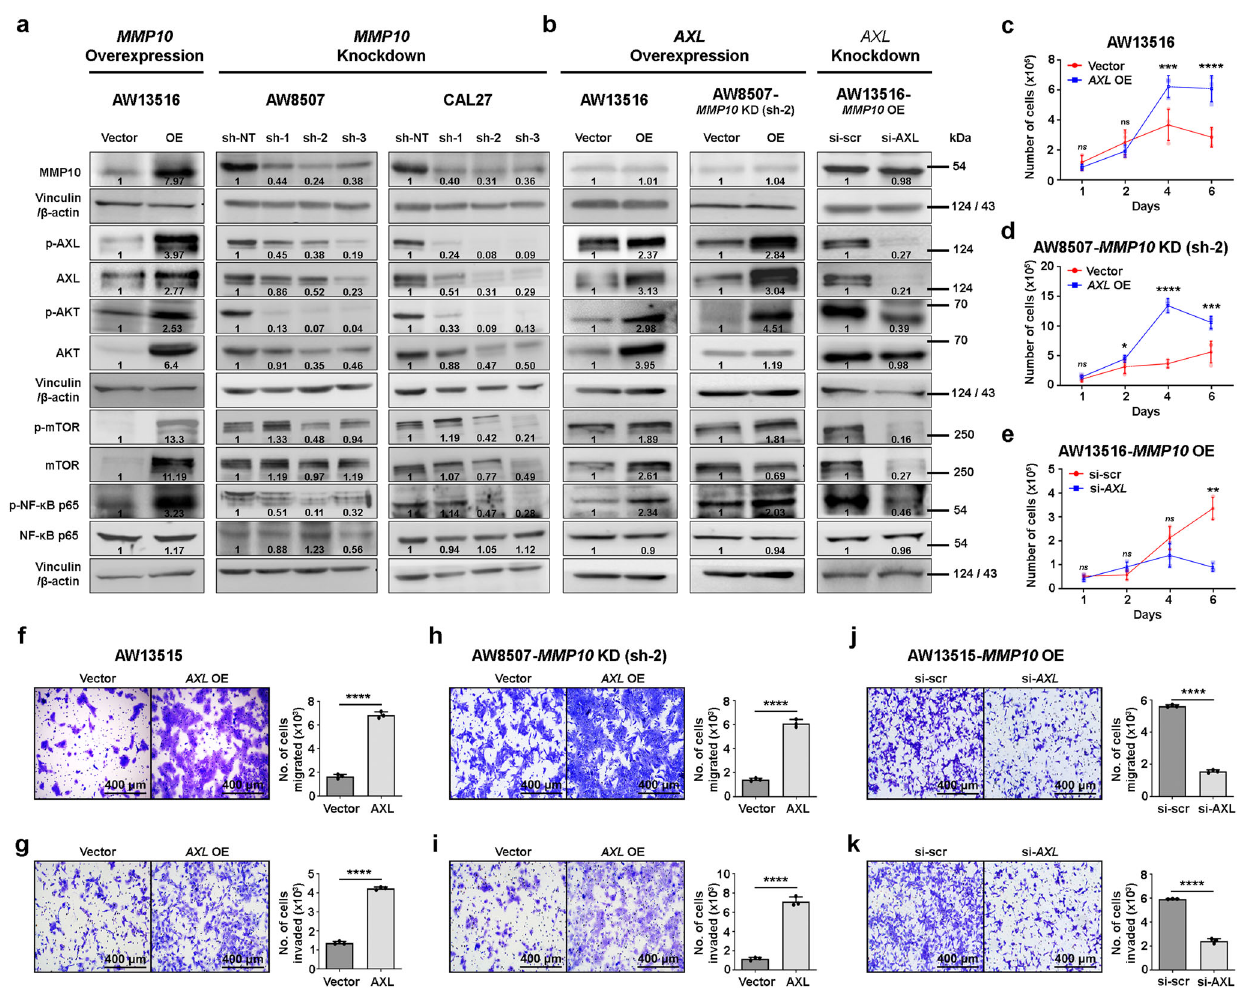
Fig. 4 miRNA-944 / MMP10 induced EMT is mediated by the AXL signaling pathway. a , b Immunoblot of MMP10, p-AXL, AXL, p-AKT, AKT, p-mTOR, mTOR, p-NF- ĸ B p65, NF- ĸ B p65, Vinculin and β -actin upon overexpression/ knockdown of MMP10 ( a ) or overexpression/ knockdown of AXL ( b ) in tongue cancer cell lines. Vinculin or β -actin was used as loading control. Numbers on the blot indicate intensity ratio of target protein expression with respect to the vector control lane. c – e Cell proliferation assay of AW13516 cells stably overexpressing empty vector or AXL ( c ), AW8507- MMP10 knockdown cells stably overexpressing empty vector or AXL ( d ) and AW13516- MMP10 overexpression cells with scrambled siRNA (si-scr) or siRNA-mediated knockdown of AXL ( e ). Scatter plots indicate the total number of live cells on the mentioned day. Boyden chamber migration ( f , h , j ) and invasion assays ( g , i , k ) of AW13516 cells stably overexpressing empty vector or AXL ( f , g ), AW8507- MMP10 knockdown cells stably overexpressing empty vector or AXL ( h , i ) and AW13516- MMP10 overexpression cells with scrambled siRNA or siRNA-mediated knockdown of AXL ( j , k ) plotted as bar plots indicating the percentage of cells migrated or invaded, respectively. Representative images of crystal violet stained Boyden chambers are shown (scale bar = 400 µ m). Data are shown as means ± SD. p -values are from Student ’ s unpaired t -test and denoted as ns (not signi fi cant); * p < 0.05; ** p < 0.01; *** p < 0.001; **** p < 0.0001. Data shown are representative of n = 3 independent